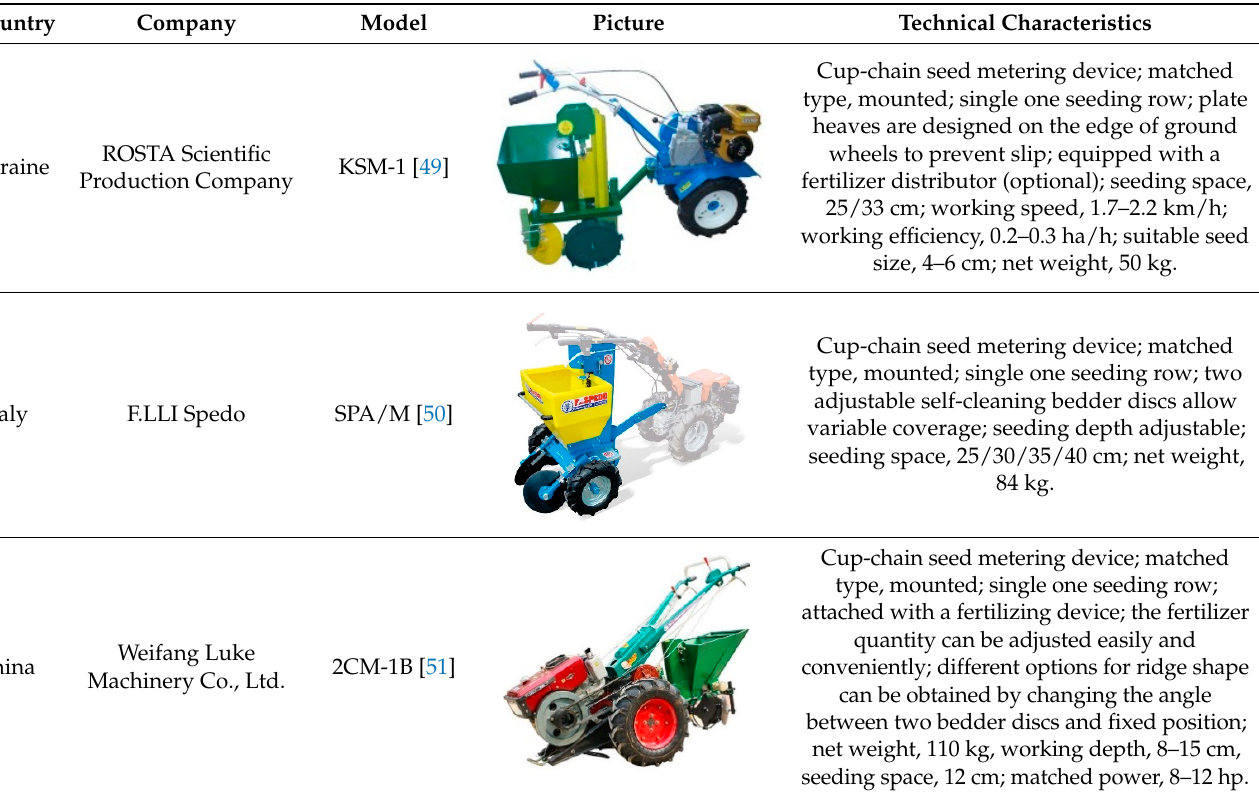
Table 2. Comparison of mechanized seed delivery planters.